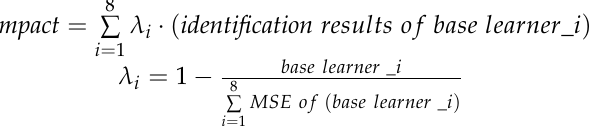
Figure 5. Schematic diagram of impact identification based on ensemble learning.